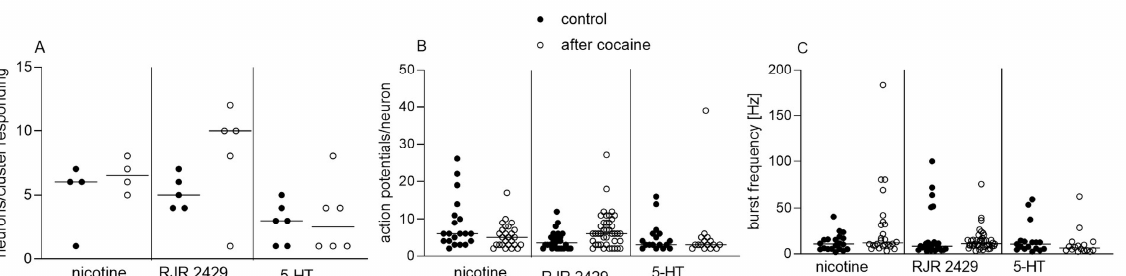
Figure 2. Effect of 24 h incubation with cocaine on responses of cultured enteric neurons to nicotine, nicotine acetylcholine receptor (nAChR) agonist RJR 2429 and serotonin (5-HT) application. Incubation of 14 d cultured enteric neurons with 10 µ M cocaine for 24 h did not affect number of responding neurons/cluster ( A ), number of action potentials fired by each neuron ( B ) or burst frequency of action potential discharge ( C ) in response to nicotine (100 µ M), RJR 2429 (10 µ M) or 5-HT (1 mM) application, respectively, compared to control dishes. Horizontal lines within data points indicate median values; n = one culture/four dishes (two control, two cocaine-incubated); each substance applied to three clusters. Mann–Whitney test.